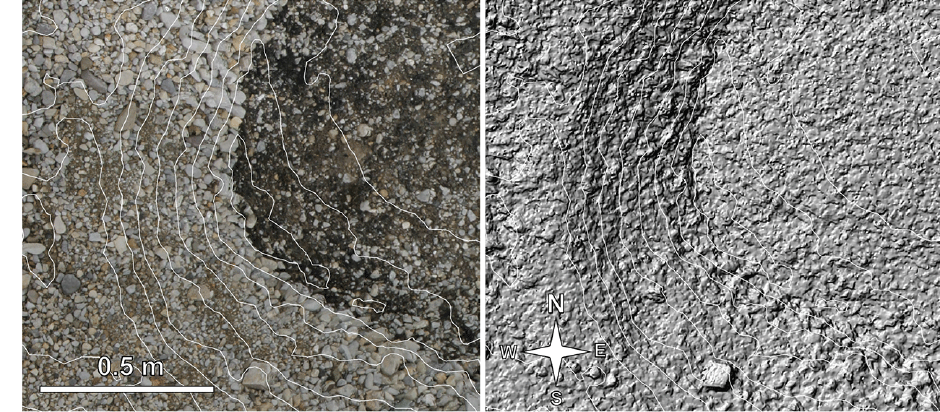
Figure 6. Section of the 2010 orthophoto (left) and DEM hillshade (right). South-western part of the northern sorted circle; for location see Fig. 5. The contour interval is 2cm (white